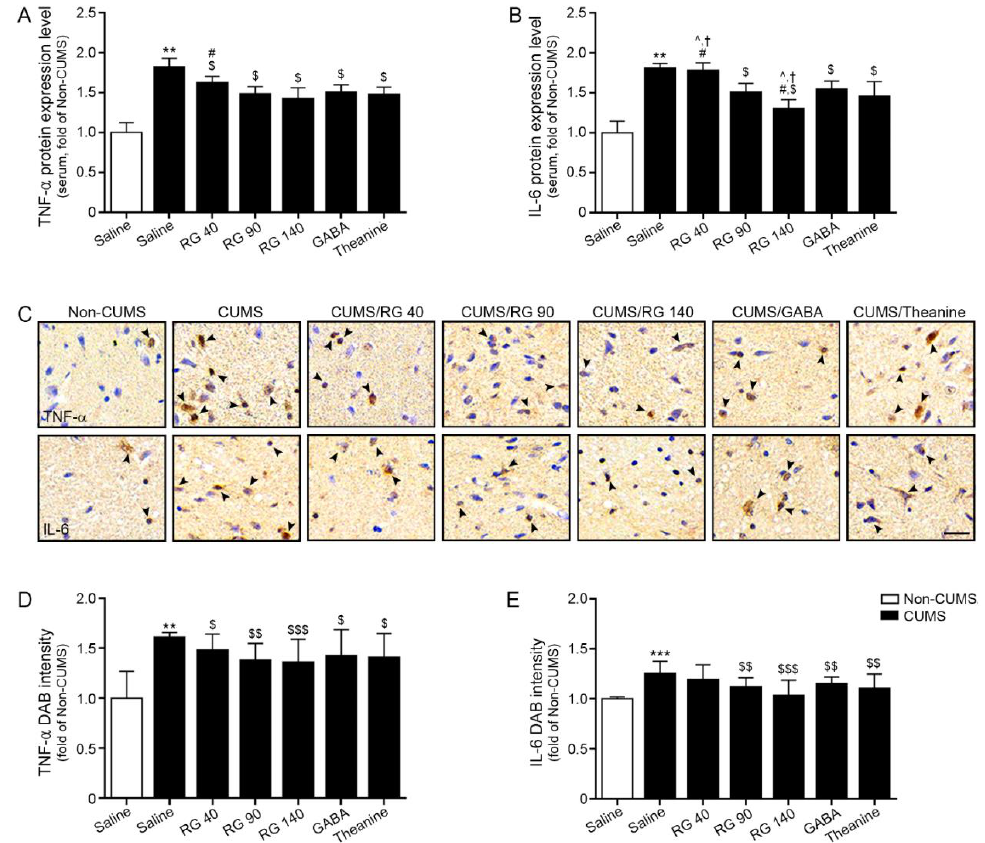
Figure 1. Reduction effect of RG on TNF- α and IL-6 expression levels in the serum and hypothalamus of CUMS mice model. ( A , B ) TNF- α ( A ) and IL-6 ( B ) protein expression levels were significantly increased in serum of CUMS compared to those in the Non-CUMS group and decreased upon RG, GABA, and theanine treatment in CUMS; ( C – E ) TNF- α ( upper lane of ( C )) and IL-6 ( lower lane of ( C )) expression levels in the hypothalamus of CUMS were validated using DAB staining ( C , scale bar = 200 µ m). Arrows point positive signals. Quantification graphs ( D , E ) are depicted in ( C ). The expression levels of TNF- α and IL-6 were higher in CUMS compared to those in control. However, their expression was decreased after RG, GABA, and theanine treatment. Data are presented as the mean ± SD ( n = 3/group). CUMS, chronic unpredictable mild stress; DAB, 3,3 (cid:48) -diaminobenzidine; GABA, gamma-aminobutyric acid; IL-6, interleukin-6; RG, rice germ with 30% GABA; TNF- α , tumor necrotic factor-alpha. **, p < 0.01 and ***, p < 0.05 vs. Non-CUMS; $, p < 0.05, $$, p < 0.01 and, $$$, p < 0.001 vs. CUMS; #, p < 0.05 vs. CUMS/RG90; †, p < 0.05 vs. CUMS/GABA; ˆ, p < 0.05 vs.